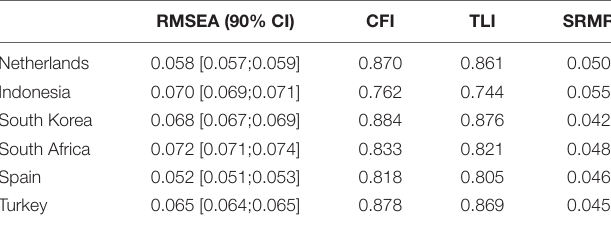
TABLE 4 | Confirmatory Factor Analysis (CFA) on the full theoretical model.